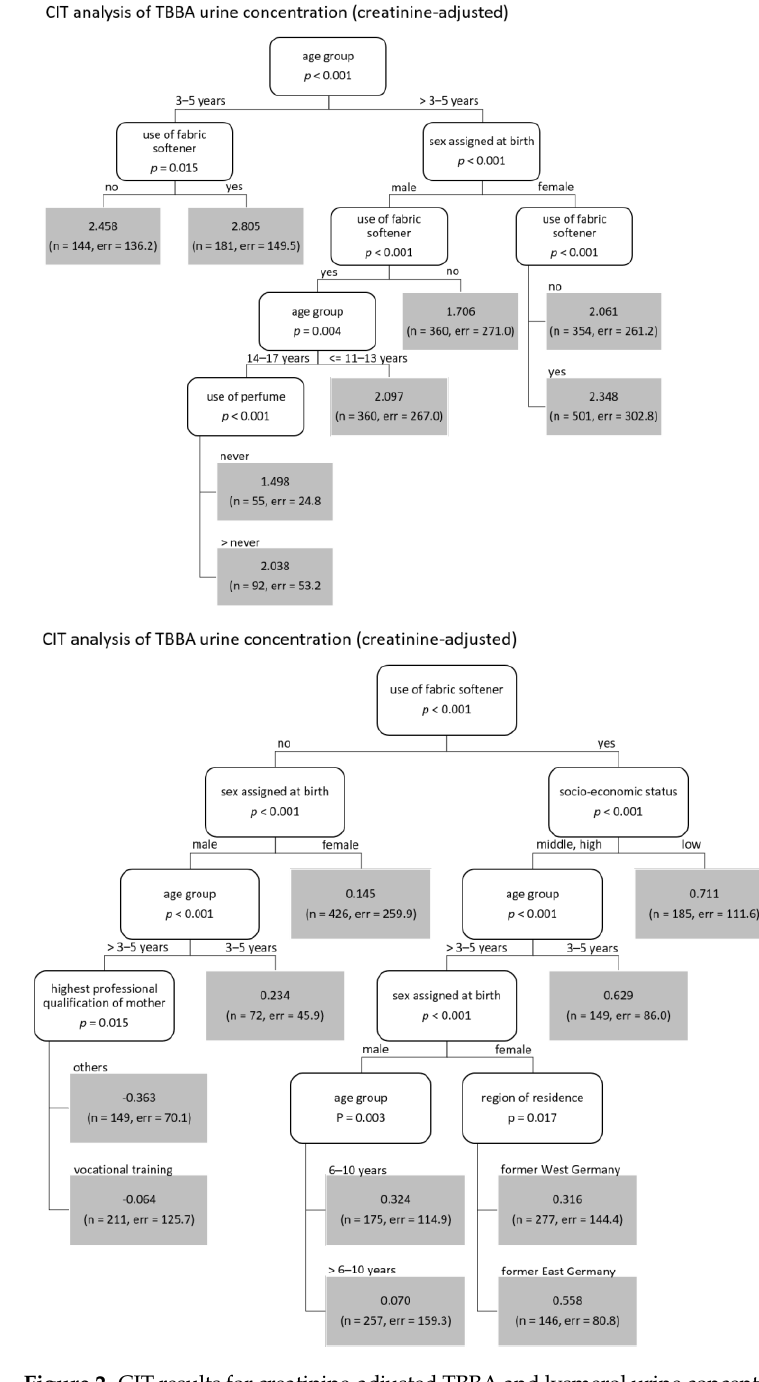
3.3. Lysmerol Metabolite Body Burden Depending on “Sex Assigned at Birth ”, “Age Group” and “Socioeconomic Status”